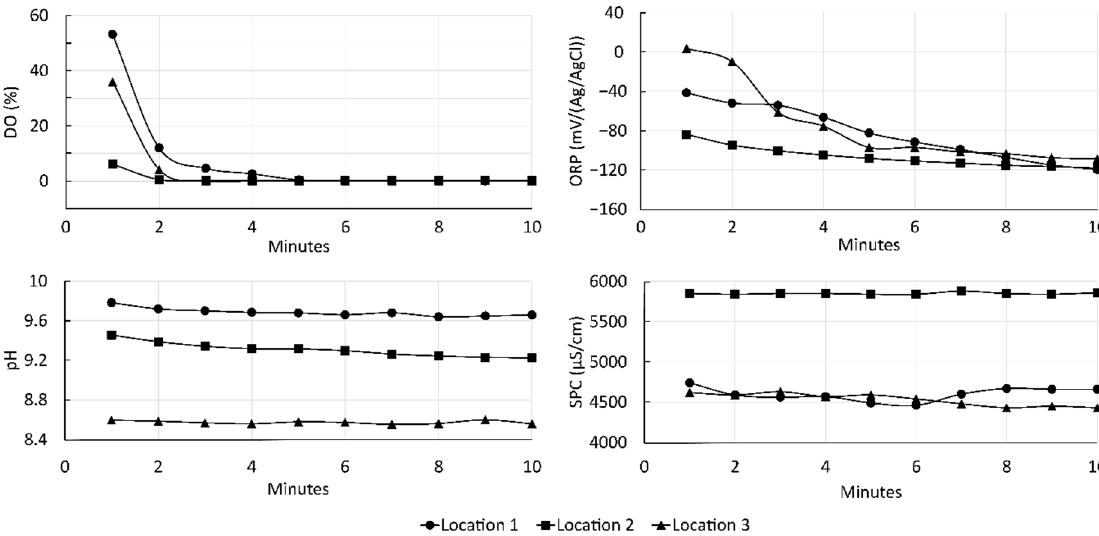
Figure 1. Variation of physicochemical readings as a function of the reading time.